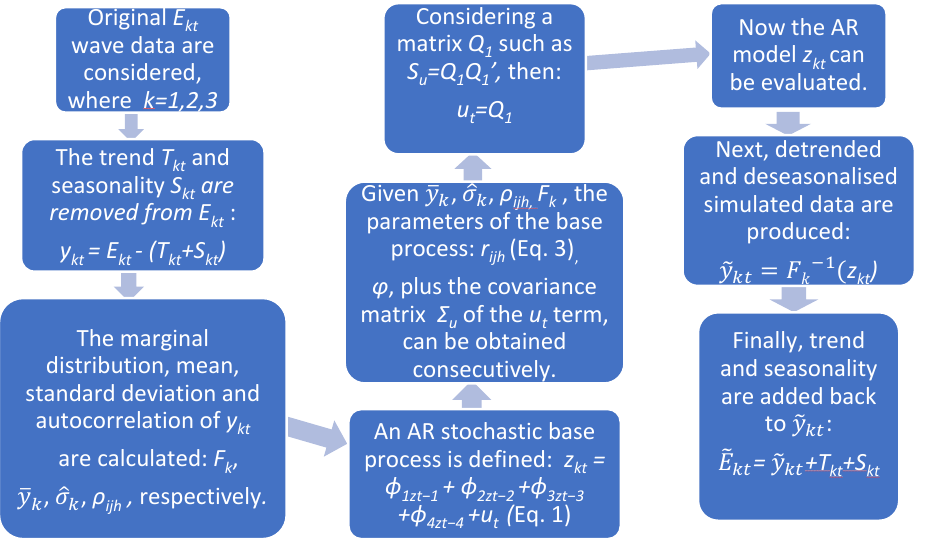
Figure 2. Schematised flow of data processing.